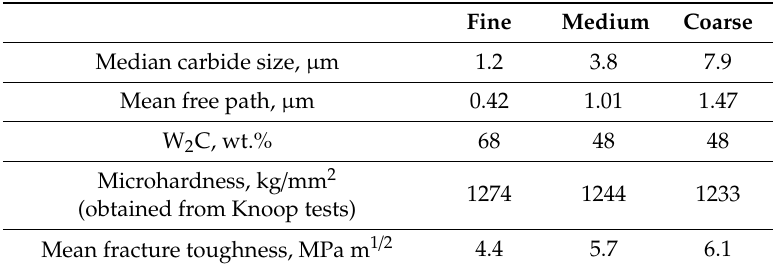
Table 2. Microstructural and mechanical properties of the HVOF WC-Co coatings investigated by Usmani et al. [16].